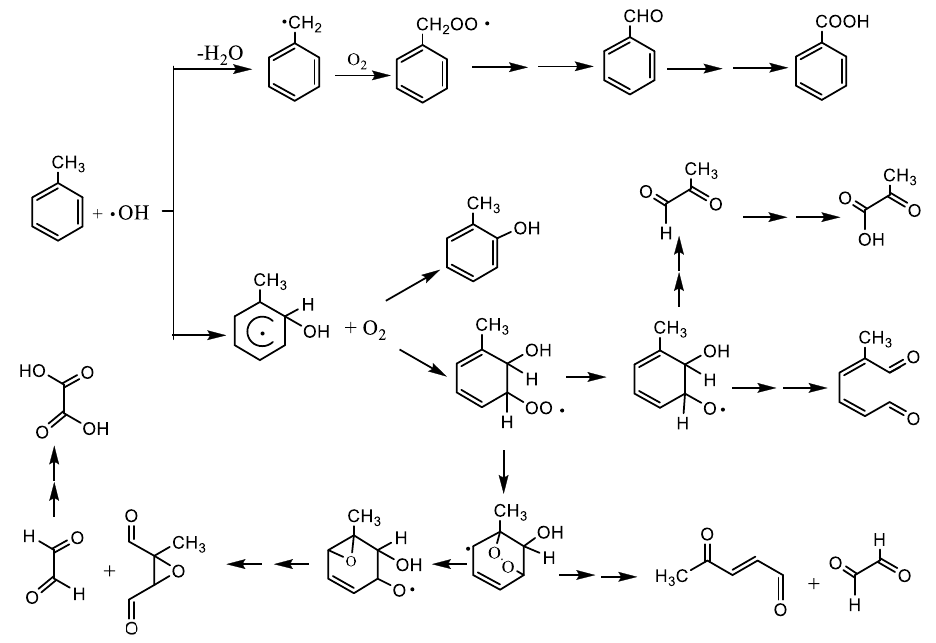
Figure 6. Suggested mechanism for aldehyde and carboxylic productions in photooxidation of toluene.